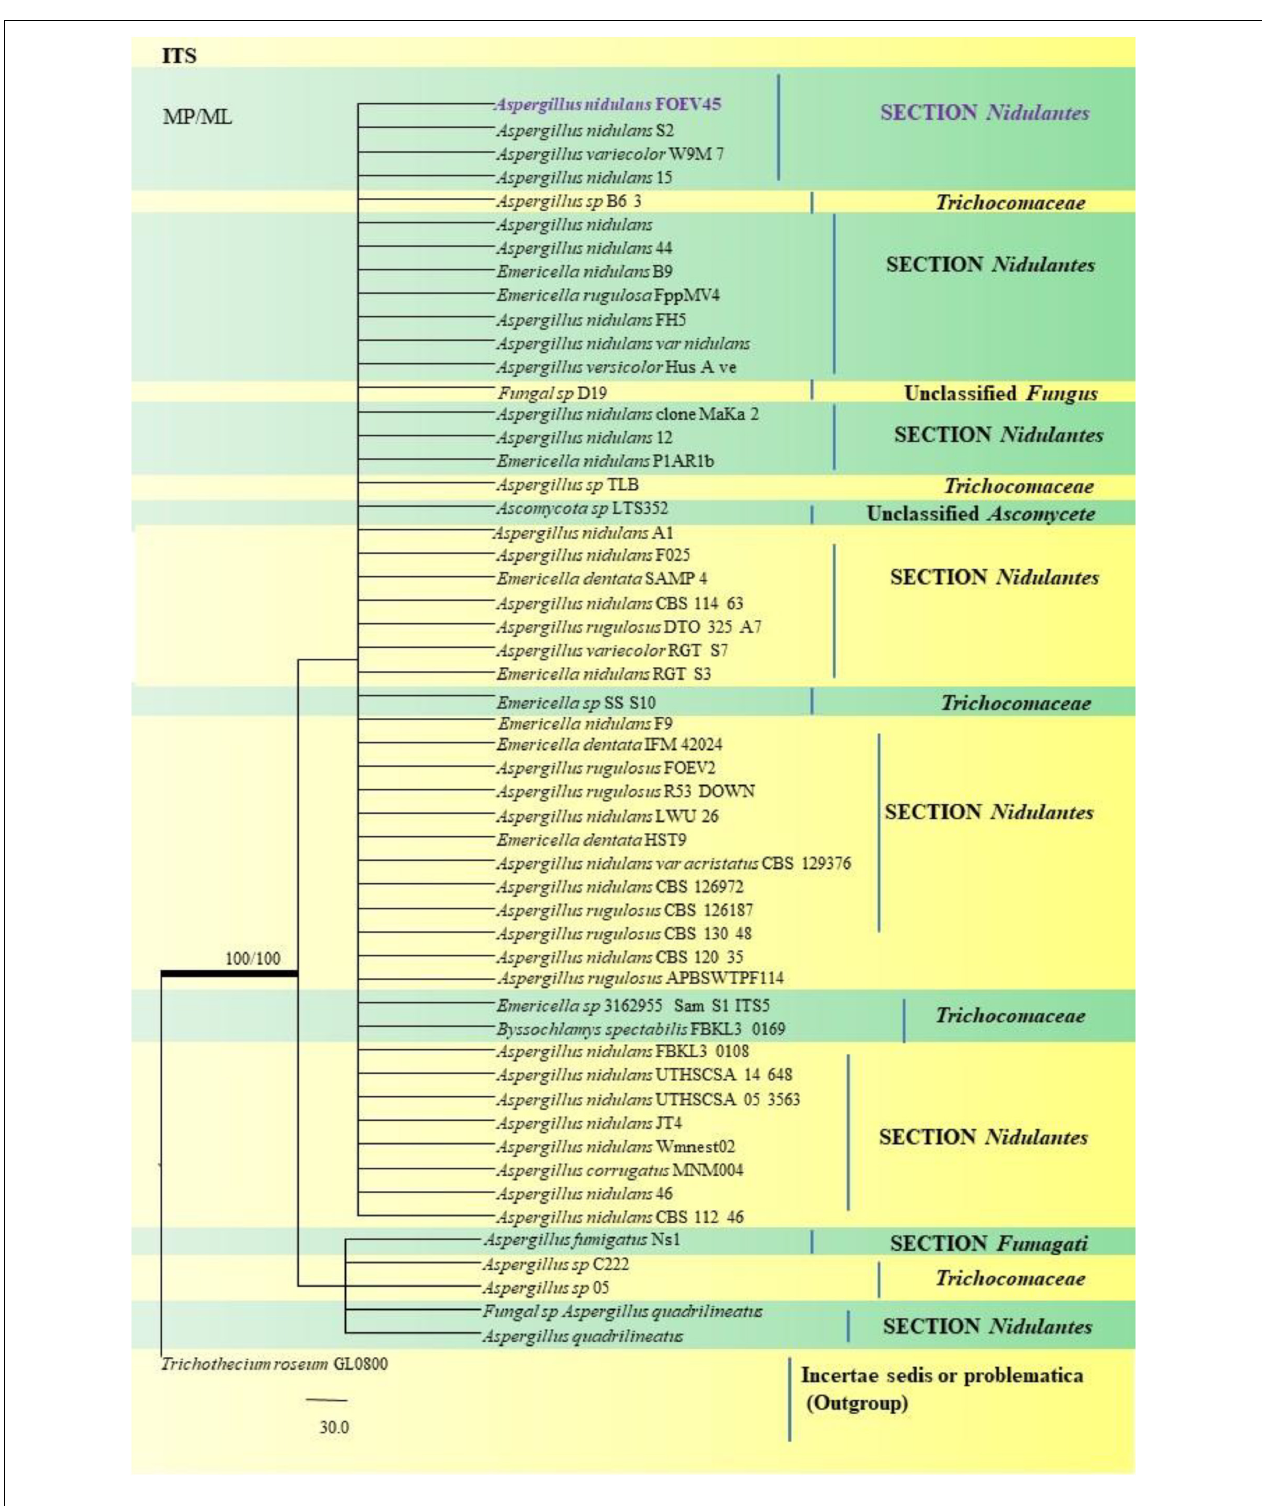
FIGURE 14 | A phylogenetic tree (taxon branching diagram) which presents the genetic analysis of the Aspergillus nidulans FOEV45 clade belonging to the Section Nidulantes , exhibiting a maximum parsimony analysis of partial ITS 1 and ITS 4 concatenated sequences, acquired. Bootstrap (bs) values ≥ 70% are designated at the nodes for maximum parsimony (MP) and maximum likelihood (ML) methods; branches with values ≥ 95% bs are bold black. A specific isolate code was mentioned as a suffix to the species name. Hyphen (-) represents the range of support values for parsimony and RAxML analyses of below 70%. Our isolate, which is marked in purple, was rooted using Trichothecium roseum